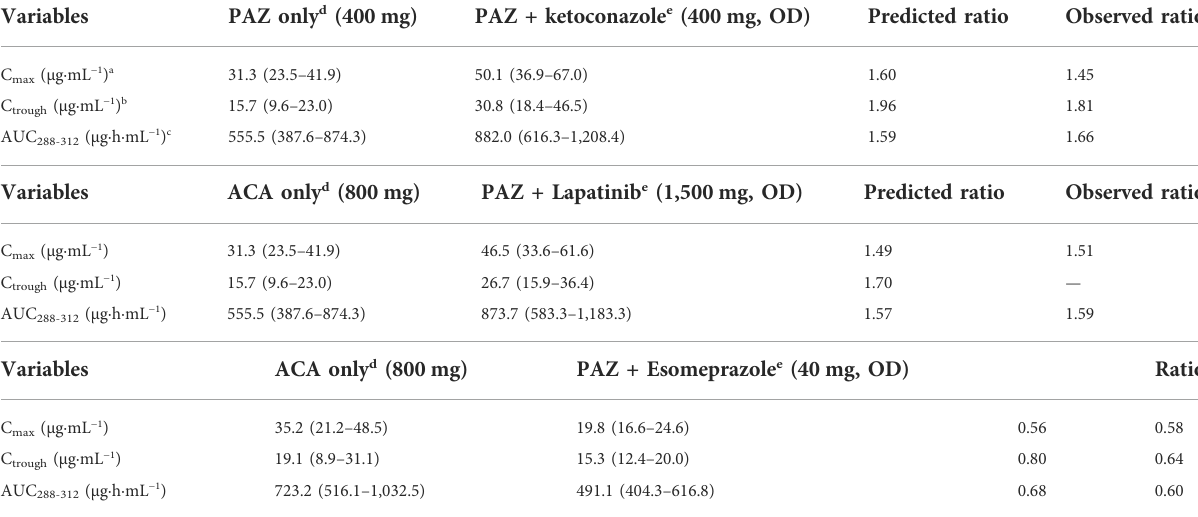
TABLE 5 PK variable changes (arithmetic mean, range) of PAZ with or without co-administration of other drugs. Variables PAZ only d (400 mg) PAZ + ketoconazole e (400 mg, OD) Predicted ratio Observed